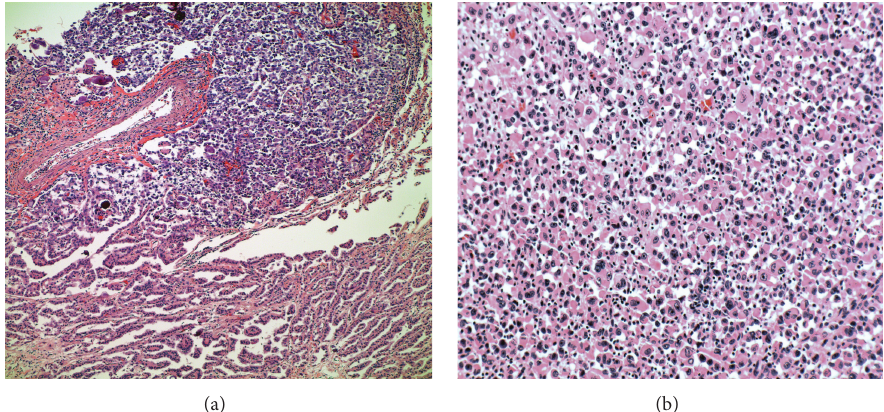
Figure 2: (a) 10x: papillary thyroid carcinoma (lower) with transformation to anaplastic carcinoma (upper). (b) 20x: higher power view of the anaplastic carcinoma component with enlarged nuclei, prominent nucleoli, and moderate amounts of eosinophilic cytoplasm.